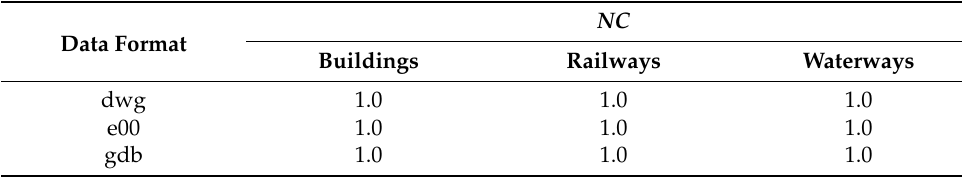
Table 12. The robustness results of format conversion